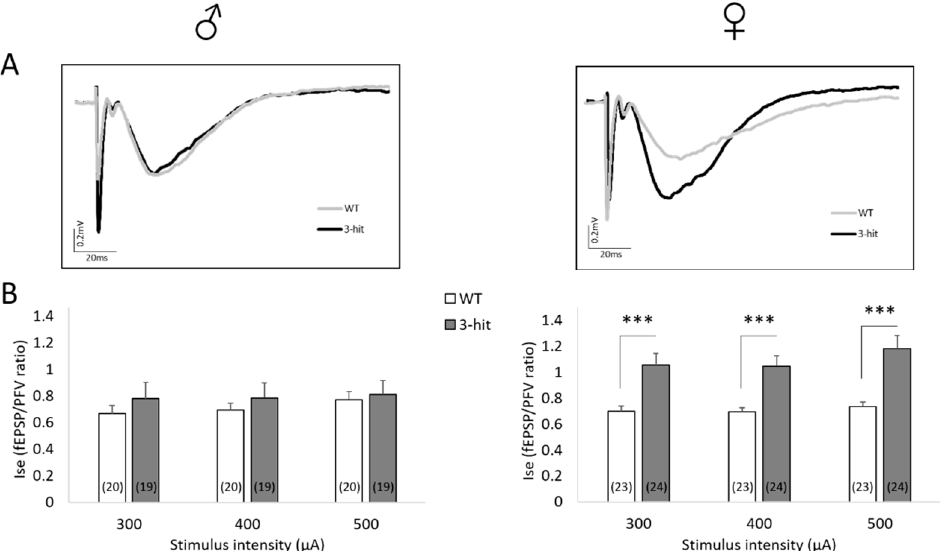
Figure 3. ( A ) NMDAr activation is specifically enhanced in female 3-hit mice. Superimposed traces of long lasting NMDAr-induced fEPSPs recorded in a slice from a male (left) and a female (right), WT (grey line) and a 3-hit (black line) mouse. ( B ) NMDAr-mediated synaptic efficacy ratio Ise (fEPSP/PFV ratio) in WT and 3-hit male (left) and female (right) mice with increasing stimulus intensity. Number of slices per group are indicated in histogram bars. Represented data are Mean ± SEM; ANOVA or ANOVA with permutation tests, ***: p < 0.001.